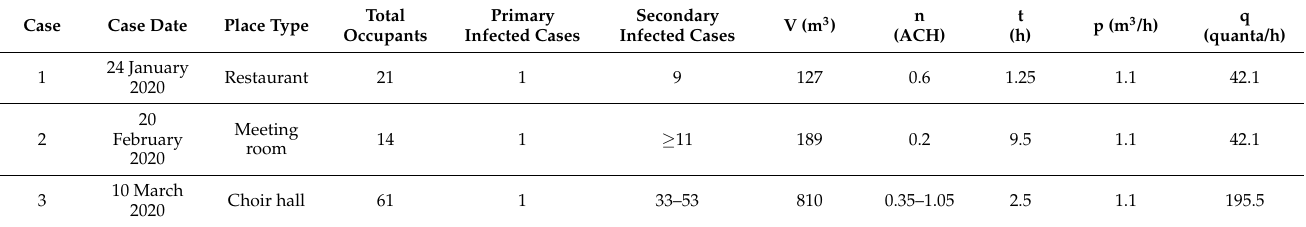
Table 2. Summary of the reported data of the COVID-19 actual cases